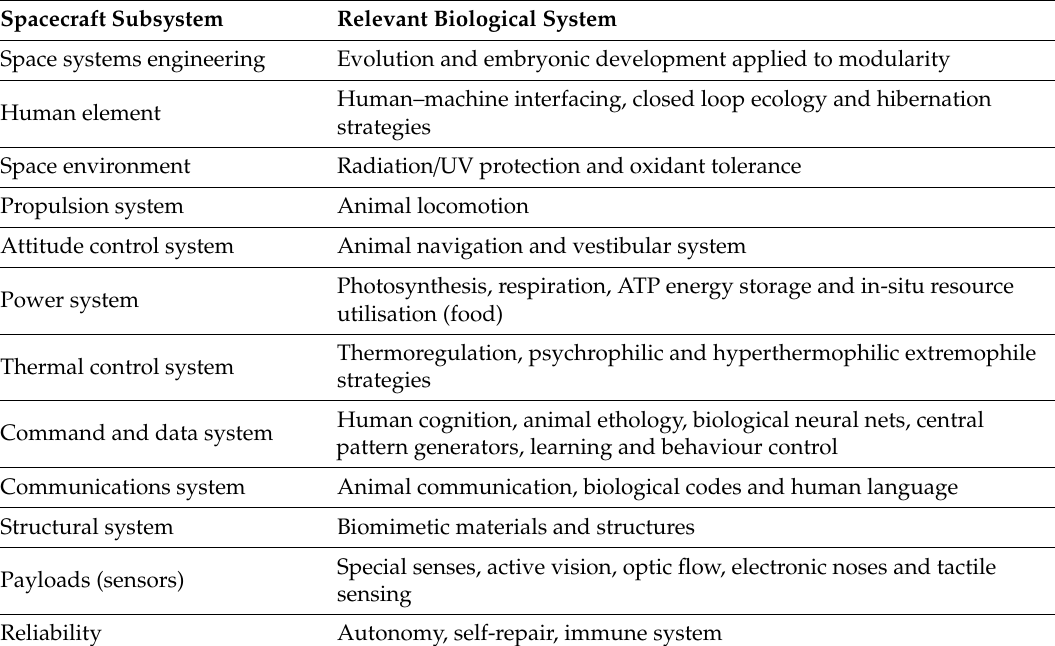
Table 1. Biological analogues of typical spacecraft subsystems.